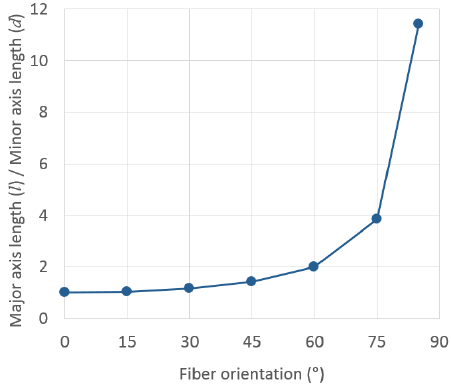
Figure 2. l / d ratio of the fiber image plotted as a function of fiber orientation, θ . Table 2. Measured orientation of the artificial fiber image according to the number of pixels in the diameter.